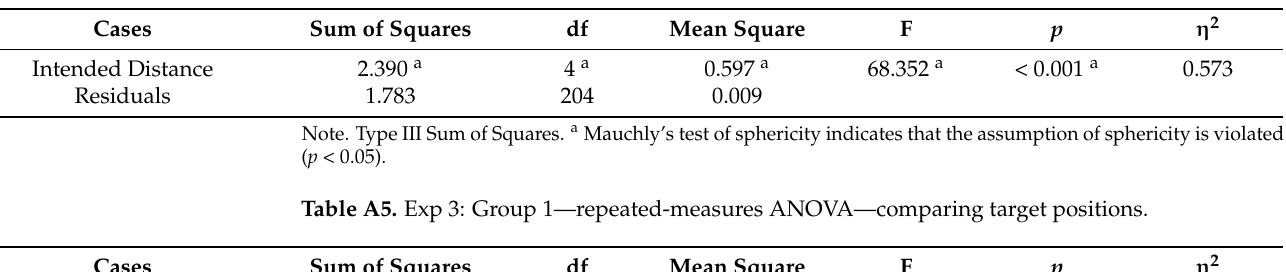
Table A4. Exp 2—repeated-measures ANOVA—comparing target sizes.